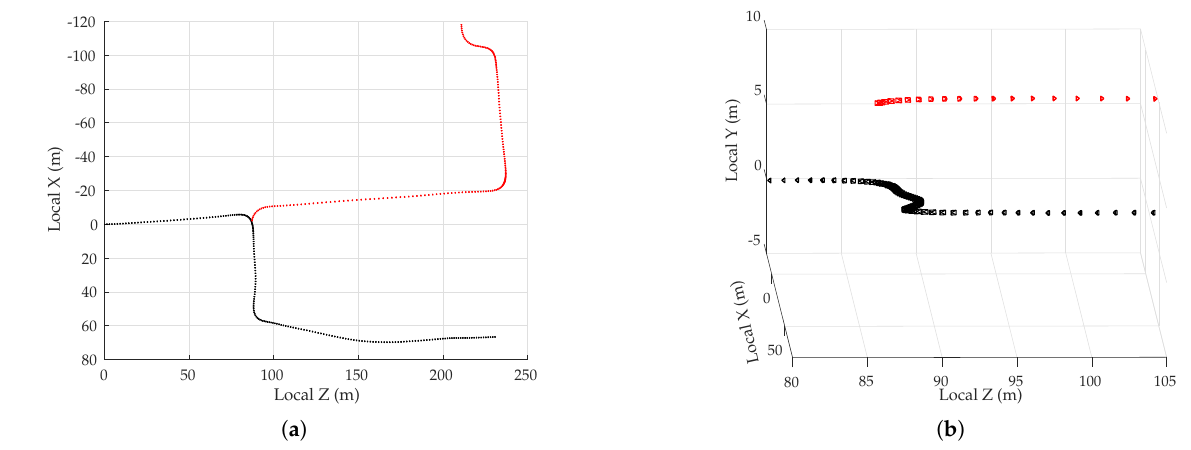
Figure 8. GEOSLAM trajectories at the instant when a merge has been detected and verified. The cameras colored black are keyframes from a prior map, and those colored red are from the current session. ( a ) Top view of the trajectories. ( b ) View from 5 ◦ elevation showing a discontinuity in the vertical component.